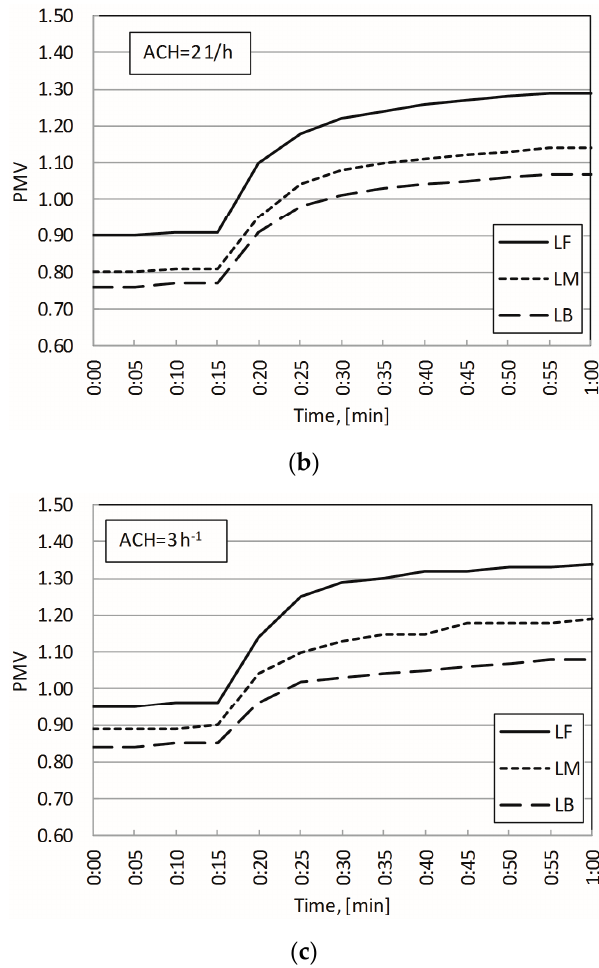
− 1 . ( b ) ACH = 2 h − 1 . ( c ) ACH = 3 h − 1